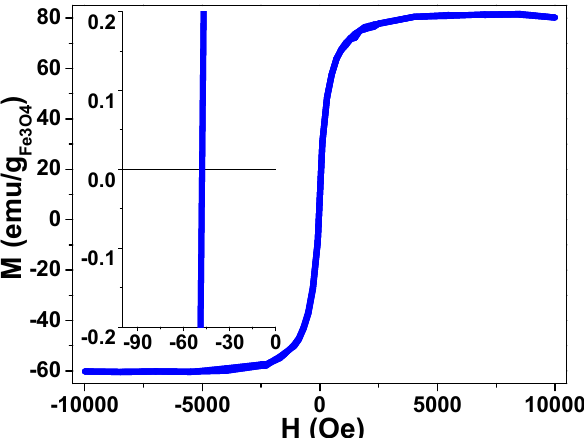
Figure 9. Magnetic hysteresis loop from 10 to − 10 kOe of HMMSN hybrid magnetic mesoporous nanorods up to 10 kOe, measured at room temperature, and a magnification of the low field region, revealing an almost absent coercive file.